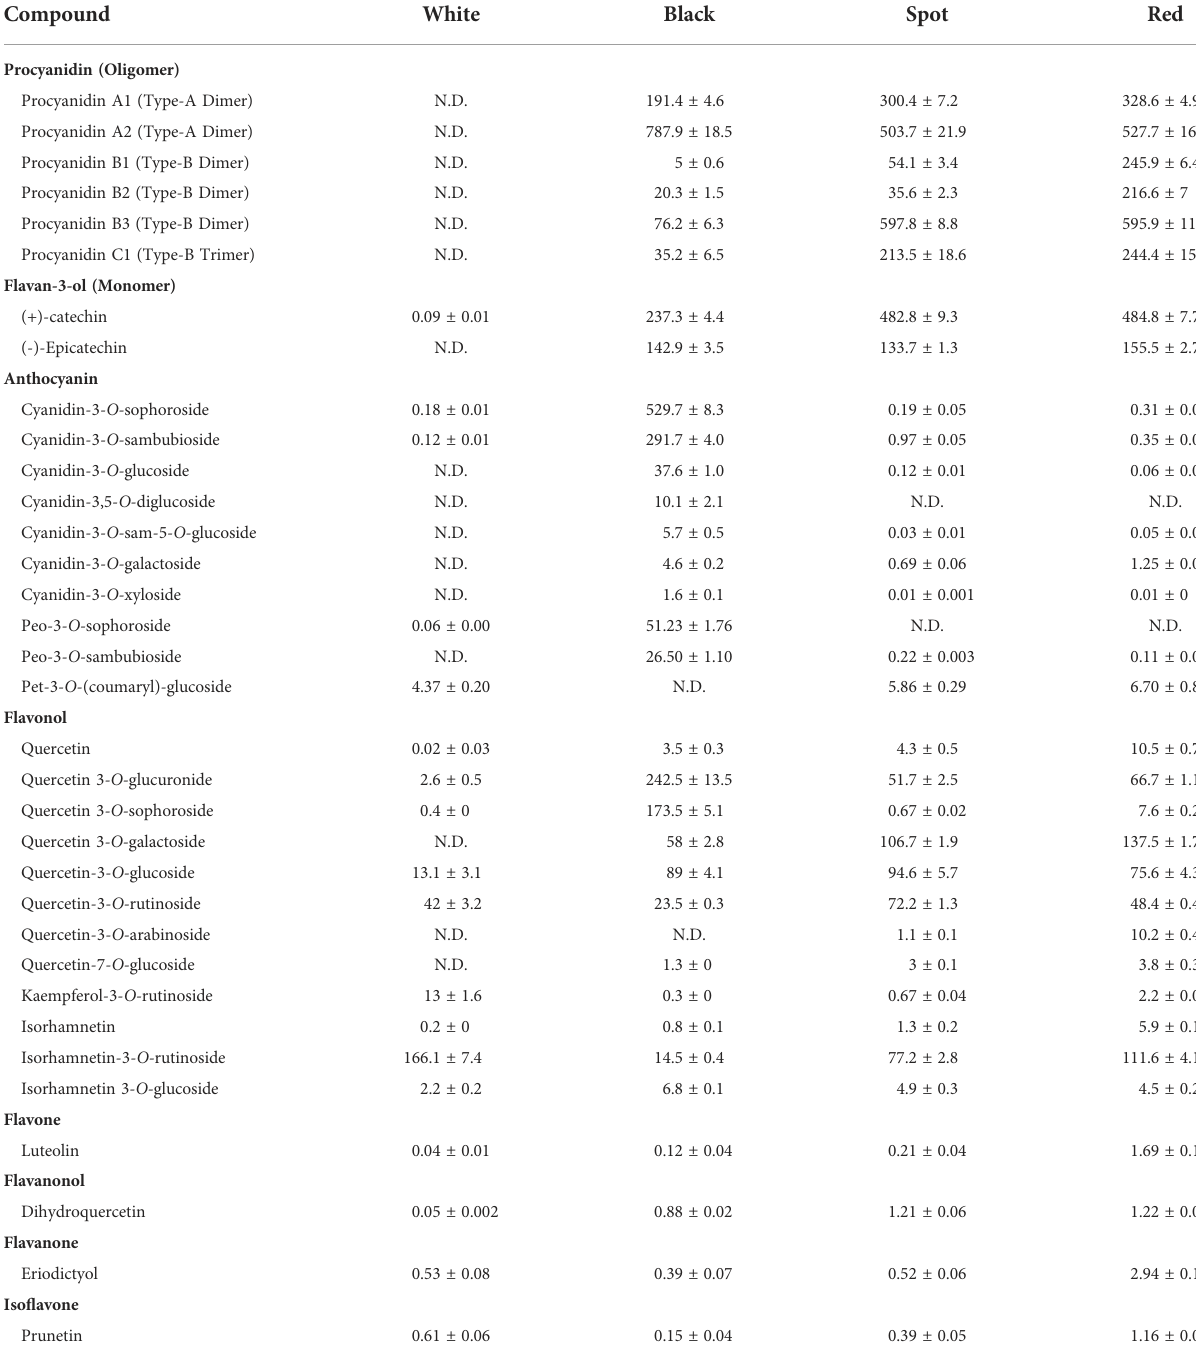
TABLE 1 The concentrations of major fl avonoid compounds in different colored peanut skins.